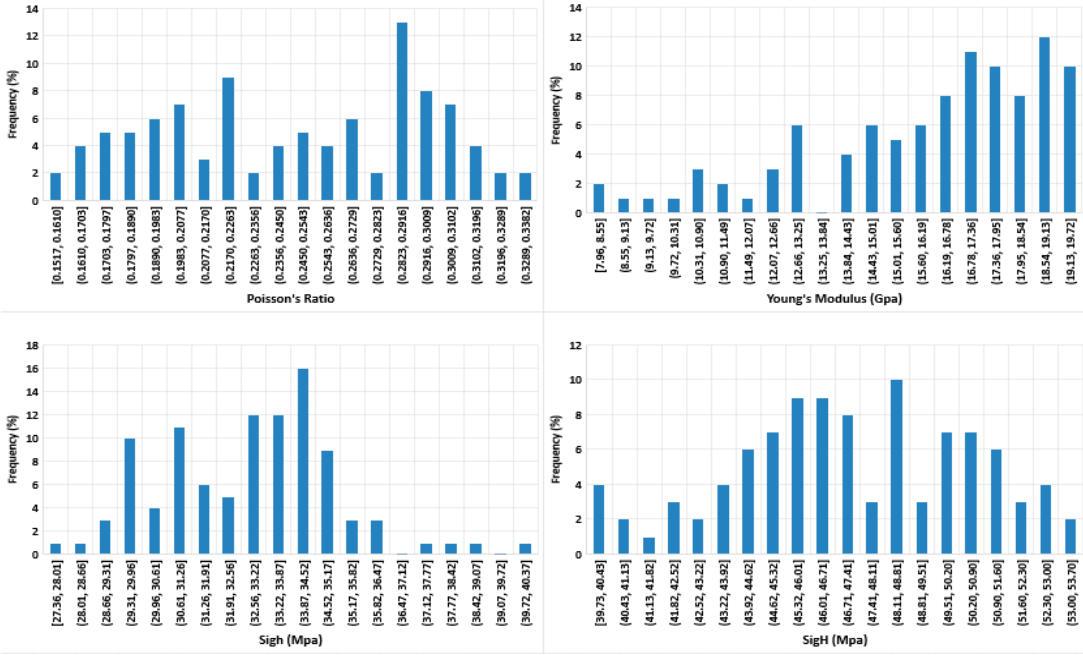
Figure 6. Histogram of Poisson’s ratio, Young’s modulus, minimum horizontal stress and maximum horizontal stress of 100 realizations of four parameters GA-ANN.